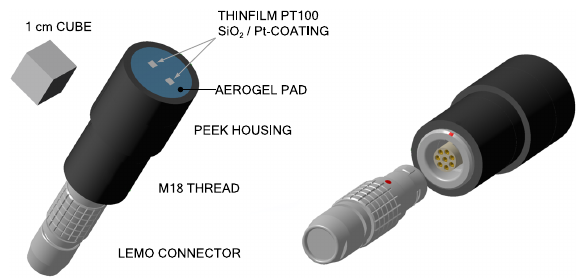
Figure 5. Design of the PHLUX sensor